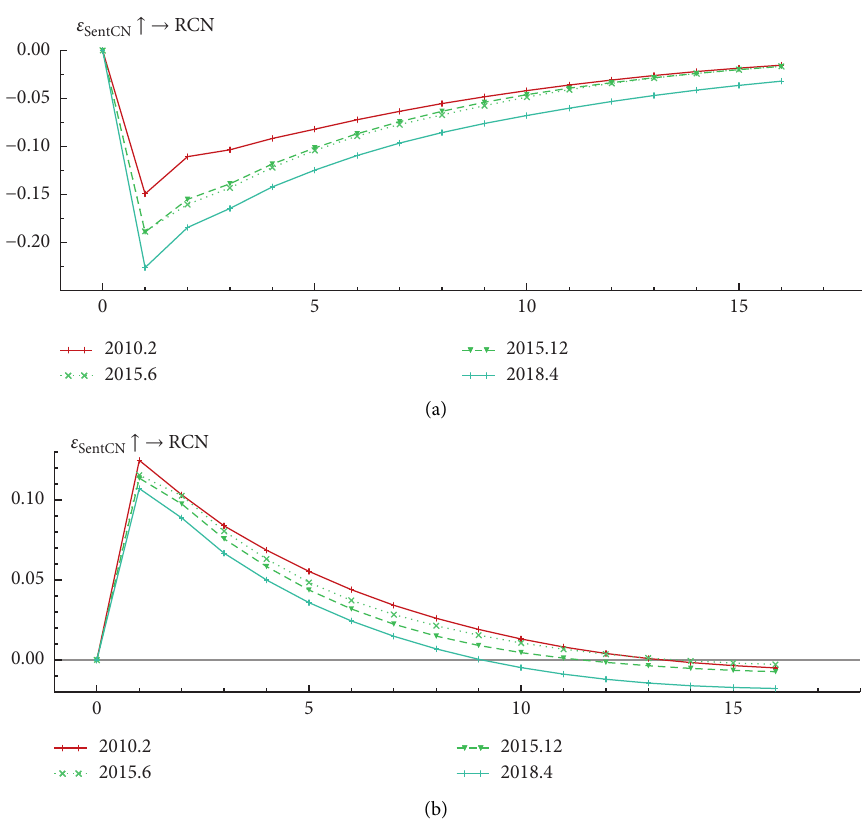
Figure 10: The impulse response of China stock market return at different time